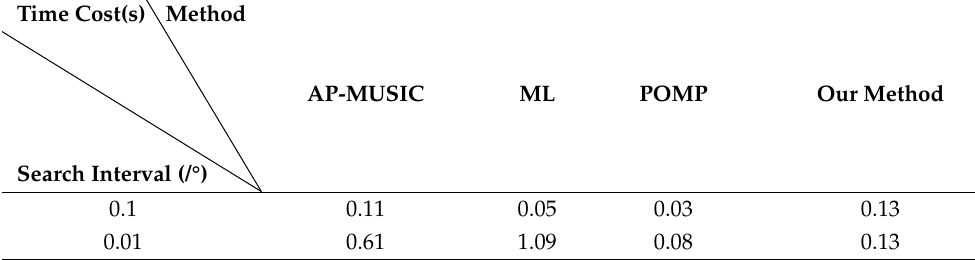
Search Interval